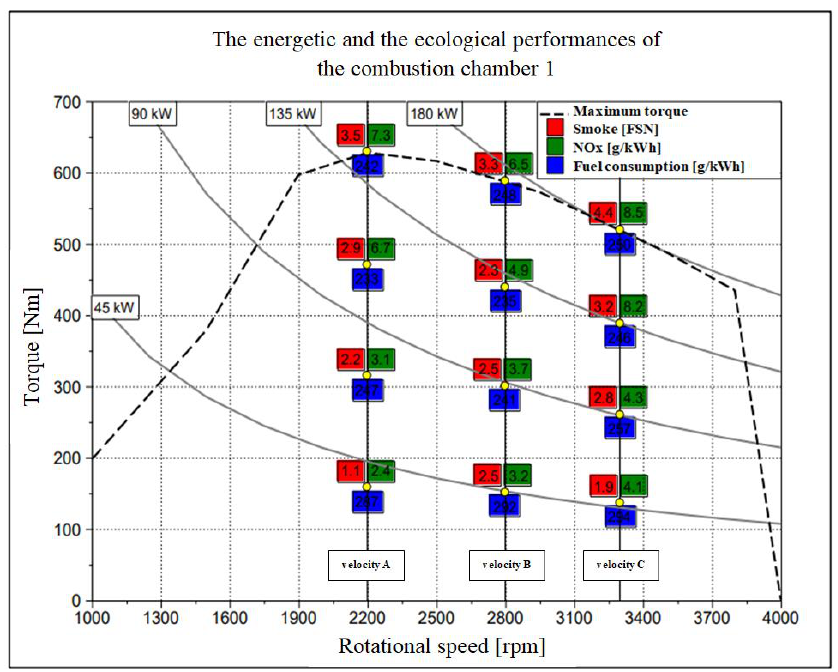
Figure 29. The energetic and the ecological parameters of the engine equipped with the combustion chamber 1 (ovoid shape).